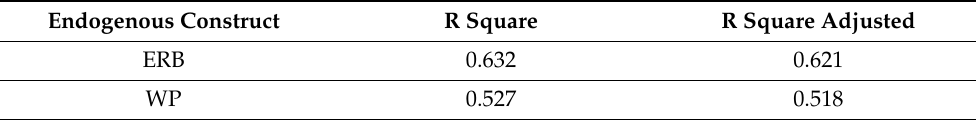
Table 6. Coefficient of determination (r 2